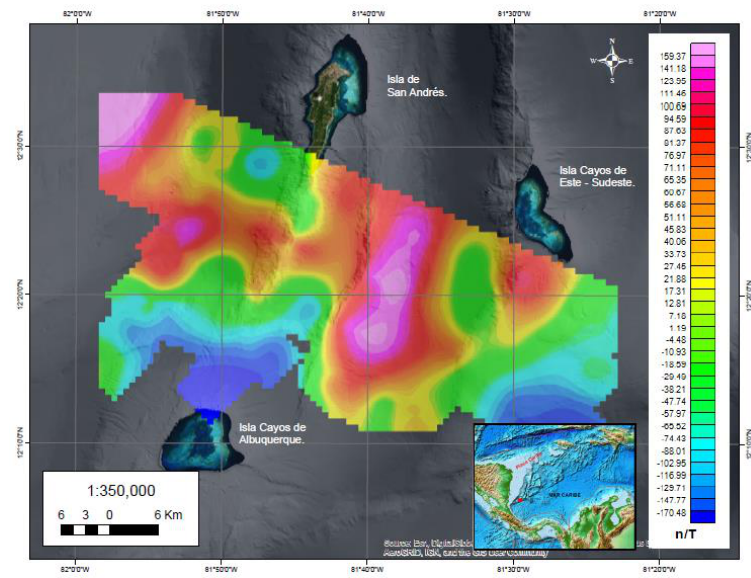
Figure 11. Geomagnetic surface of the total field with corrections.